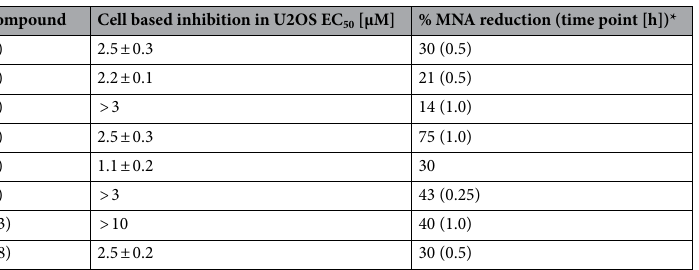
Table 3. Cell based NNMT inhibition and determination of MNA in cells (Target engagement). *Time point after addition of compound at which maximal MNA reduction was observed relative to control without